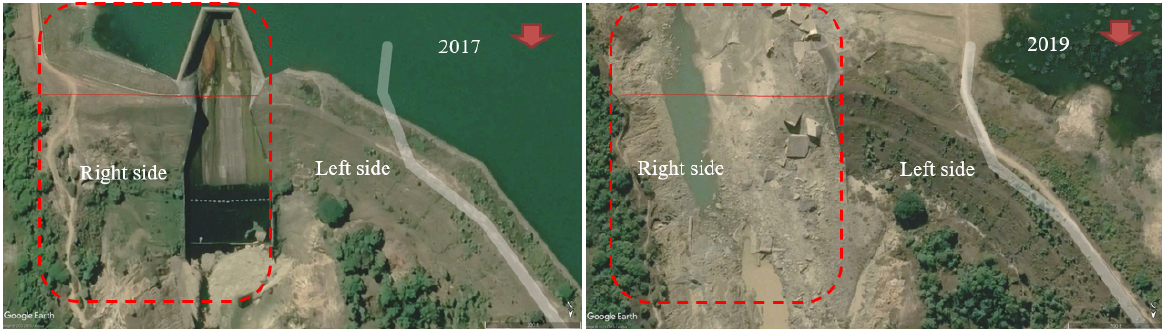
Figure 4. Collapsed spillway before and after the breach event (Google Earth images).